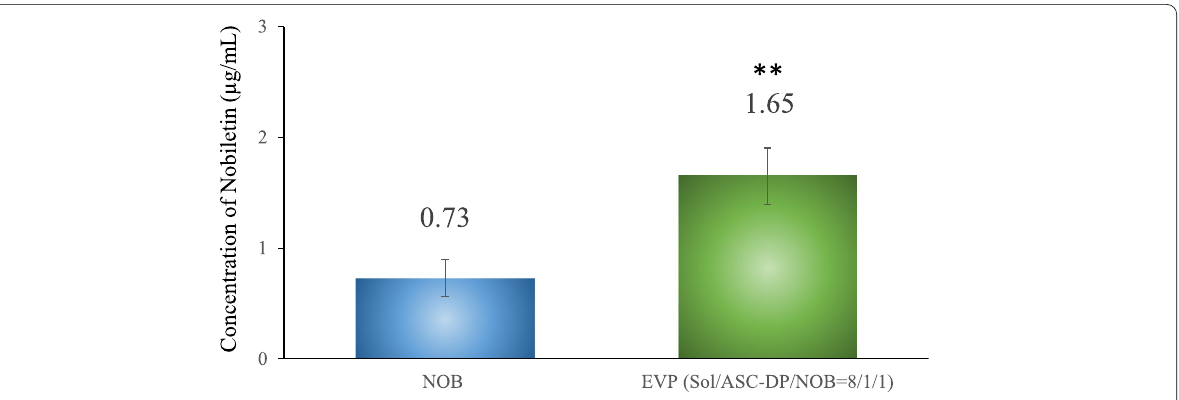
8/1/1). a , c Objective 4; = ×